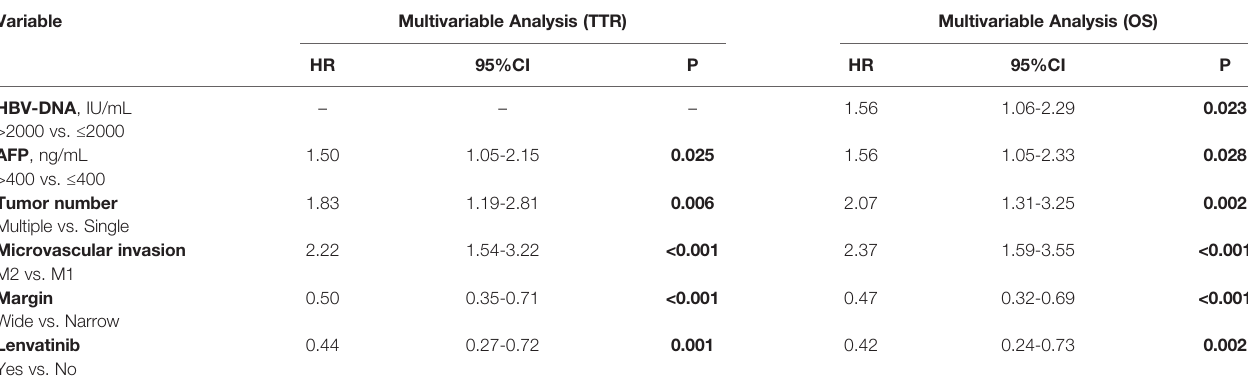
TABLE 5 | Multivariate Cox-regression analysis for predicting TTR and OS in 293 HCC patients with Microvascular Invasion with and without adjuvant Lenvatinib before PSM.